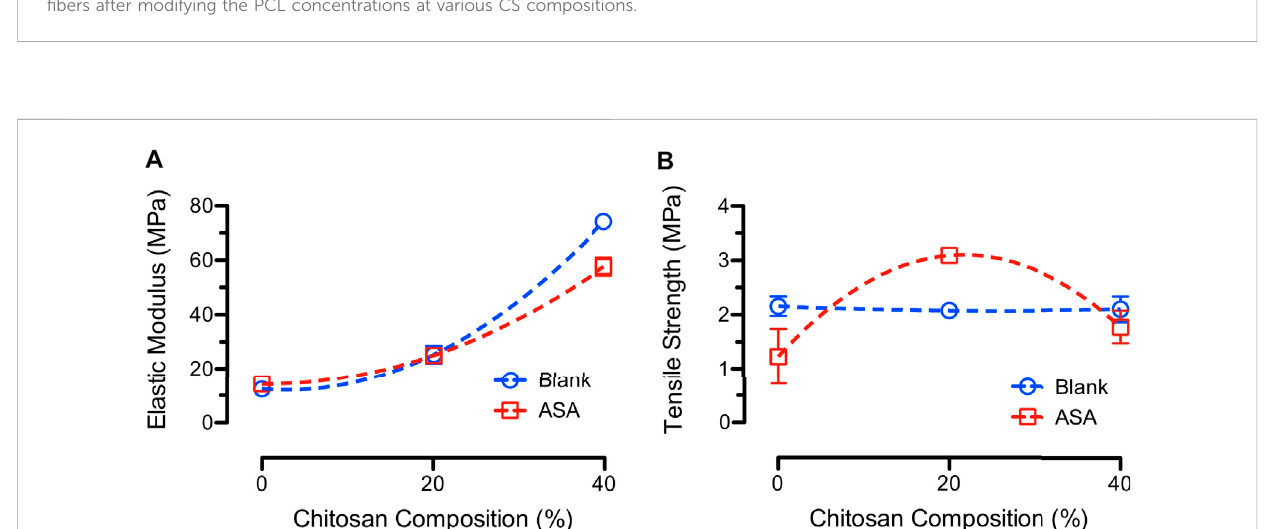
FIGURE 9 (A) Average elastic moduli and (B) average tensile strength of blank (blue) and ASA-loaded (red) PCL/CS blend fi bers after modifying the PCL concentrations at various CS